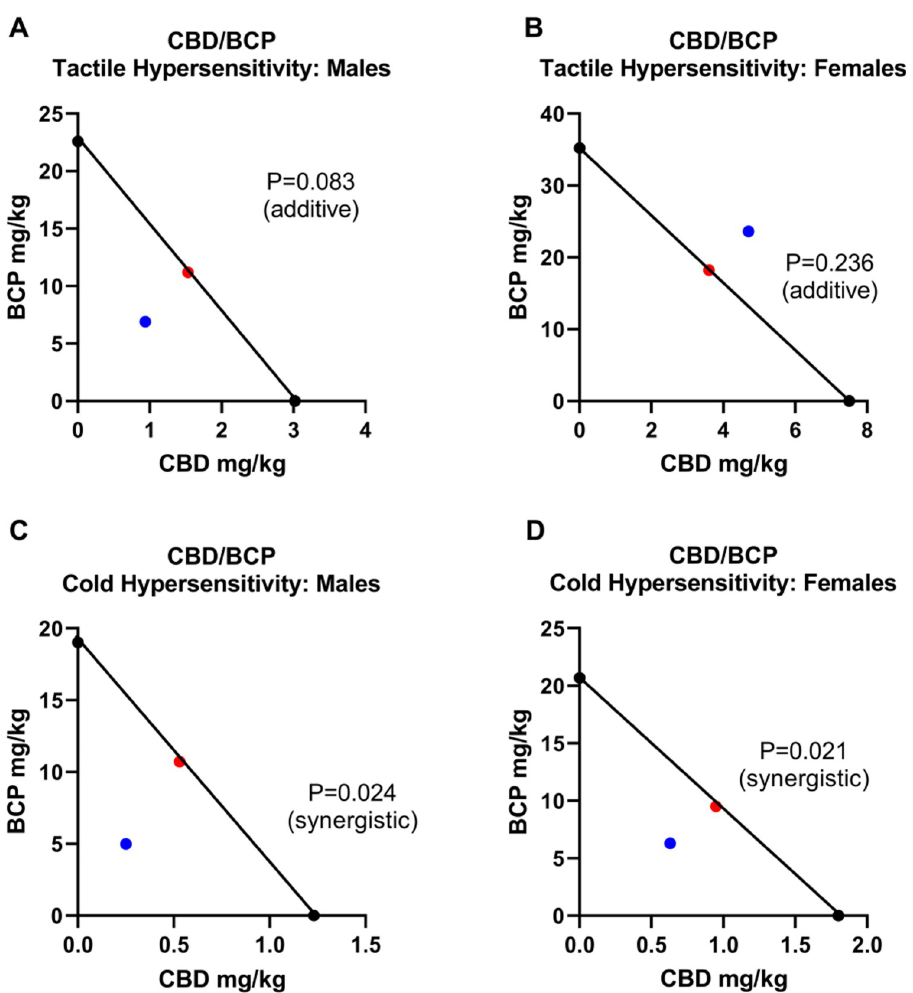
Fig 7. Isobolographs of CBD and BCP antinociceptive effects in combination in males and female rats. Isobolographic analyses for combination CBD and BCP treatment on mechanical paw withdrawal threshold in A) males and B) female rats and acetone responses in C) males and D) female rats. P values and the effect are indicated. overall F (1,10) = 5.669, p = 0.0385. A similar trend was observed in intact females, but this was not statistically significant (Fig 8D); overall F (1,10) = 0.3320. No effect of CBD/BCP was observed in the catalepsy bar test in either male or female non-injured rats. In contrast, WIN 55,212–2 induced significant catalepsy starting 30 min post-injection through 5 hours in male rats (p = 0.0099, 0.0049 and p < 0.0001 respectively vs baseline), and strong differences between groups were observed with overall F(1,9) = 63.23, p < 0.0001 (Fig 8E). In females, WIN 55,212– 2 injection also caused significant catalepsy 30 min-5 hours post injection (with p value at least < 0.05 compared with pre-injection baselines, and significant differences between the drug treatments (overall F(1,10) = 31.09, p = 0.0002; Fig 8F). In SCI animals, no significant effects of the CBD/BCP combination were observed in body temperature or bar tests (p = 0.8650 compared with pre-injection baseline; S1 Fig). However, significant hypothermic effects of WIN 55212–2 were observed in this group from 30 min– 2 hrs post-injection in both males and females (p at least < 0.01). There was also a transient (at 30 min) significant enhanced catalepsy behavior in male SCI rats (p = 0.0418).